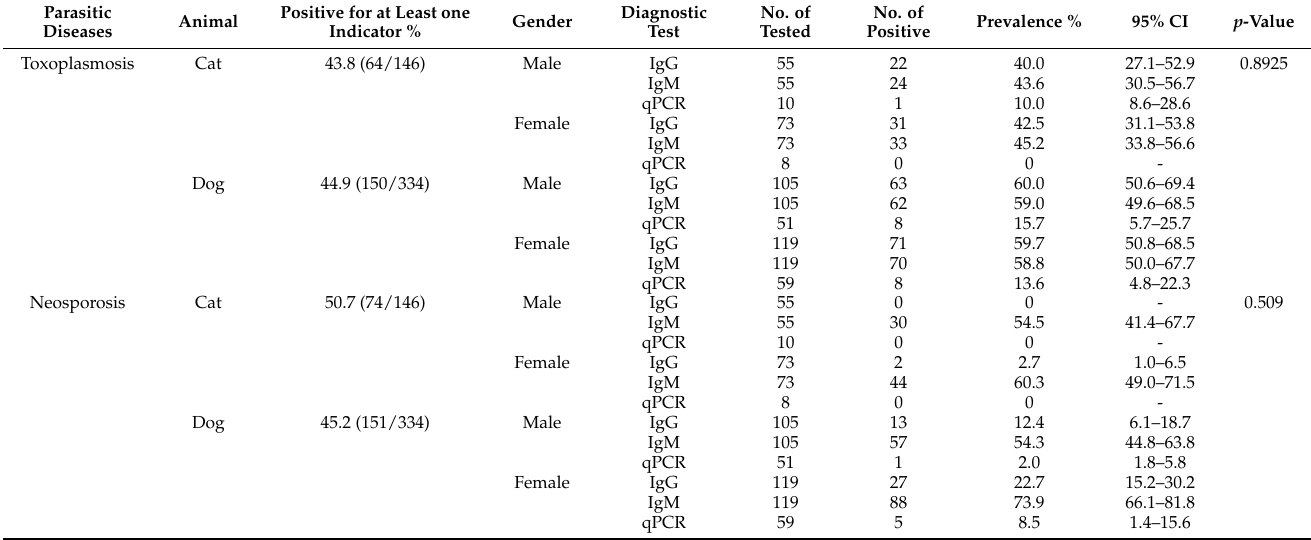
Table 4. Toxoplasmosis and neosporosis in stray cats and dogs in the QTPA,